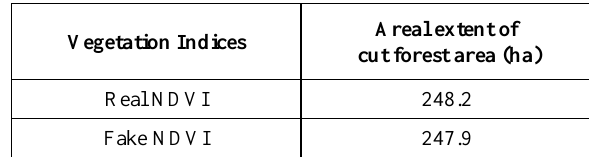
Table 4. Difference maps in cut forest area (ha) for real and fake